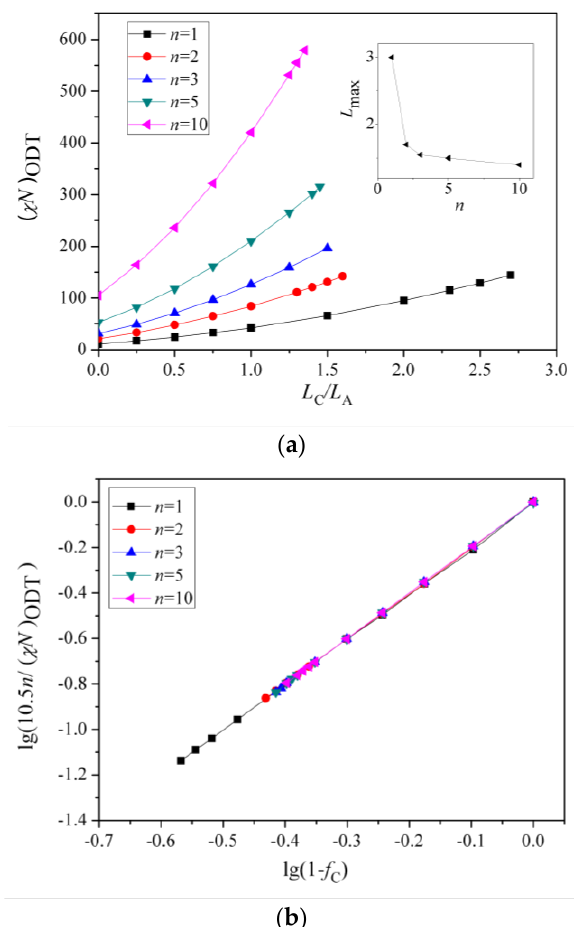
Figure 4. ( a ) The (𝜒𝑁) ODT values for the Janus double-brush copolymer (AC 2 B) n with different architectural periodicity n of star subunits and different ratios between the lengths of the arm C and arm A chains 𝐿 C 𝐿 A ⁄ . ( b ) The double logarithmic plot of the (𝜒𝑁) ODT values versus the composition of the C segments f C . All data fall on the same line, and the linear line can be fitted nicely by the same formula (𝜒𝑁) ODT = 10.5𝑛(1 − 𝑓 C ) −2 .